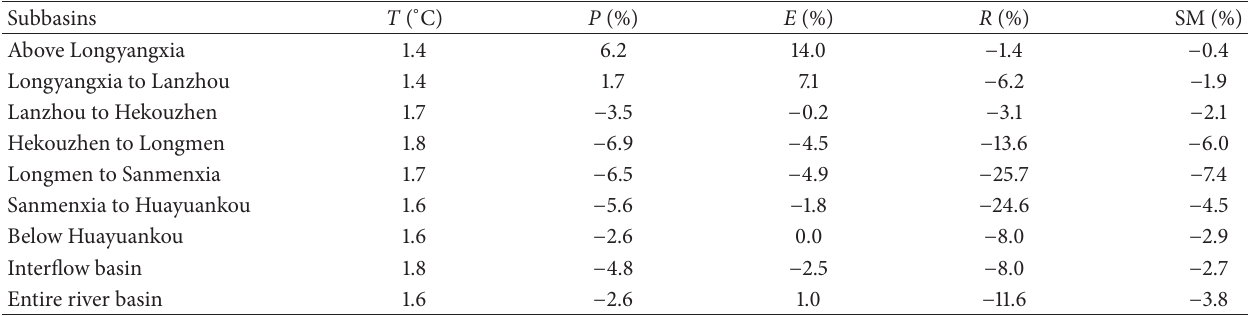
Table 4: Projected changes in mean annual temperature ( T ), precipitation ( P ), evapotranspiration ( E ), runoff ( R ), and soil moisture (SM). Subbasins